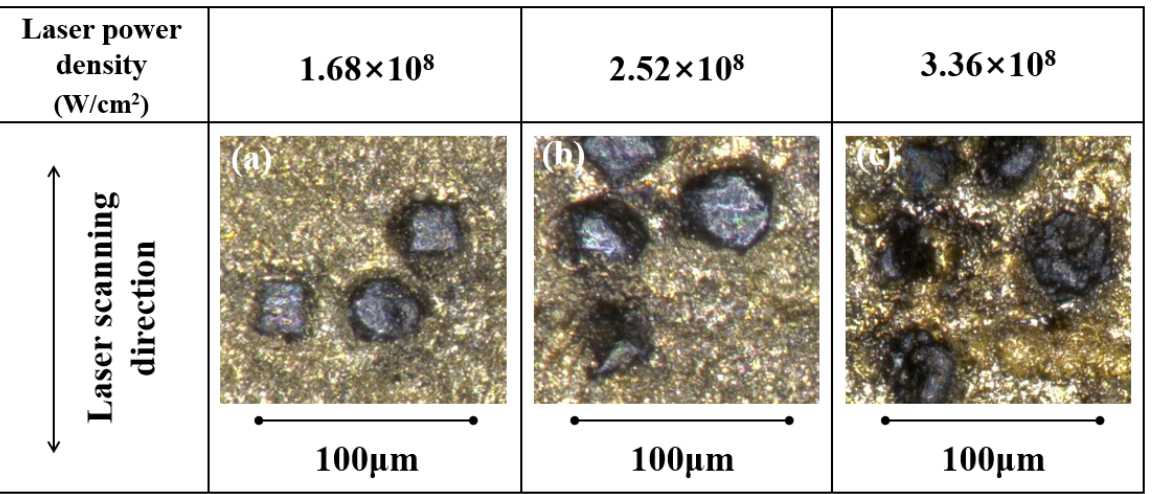
Figure 18. Topography of the bronze-bonded diamond abrasive grinding wheel after pulsed fiber laser dressing. ( a ) Laser power density: 1.68 × 10 8 W/cm 2 ; ( b ) Laser power density: 2.52 × 10 8 W/cm 2 ; ( c ) Laser power density: 3.36 × 10 8 W/cm 2 .